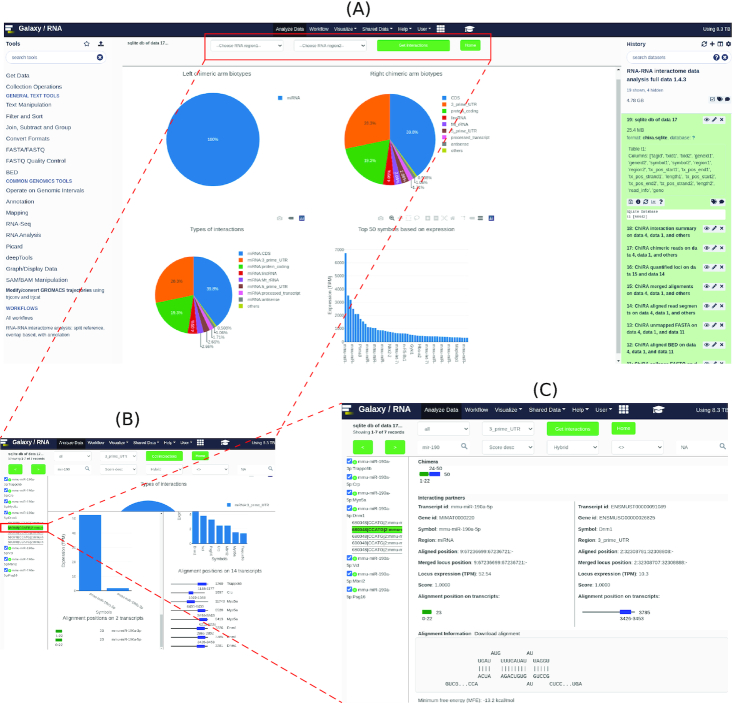

ChiRAViz Galaxy visualization. (A) The home page of the visualization. The plots on this page summarize the RNA biotypes of left and right chimeric arms, types of interactions, and highly abundant genes within the sample. (B) The second page shows the interactions of selected biotypes. On this page, users can further search, sort, and filter the interactions and obtain a deep summary of filtered interactions. (C) Interaction information page that shows such useful information as gene symbol, transcript IDs, gene IDs, expression level, biotypes, a depiction of interaction reference regions at transcript level, an illustration of the aligned read positions, and IntaRNA predicted hybrid.